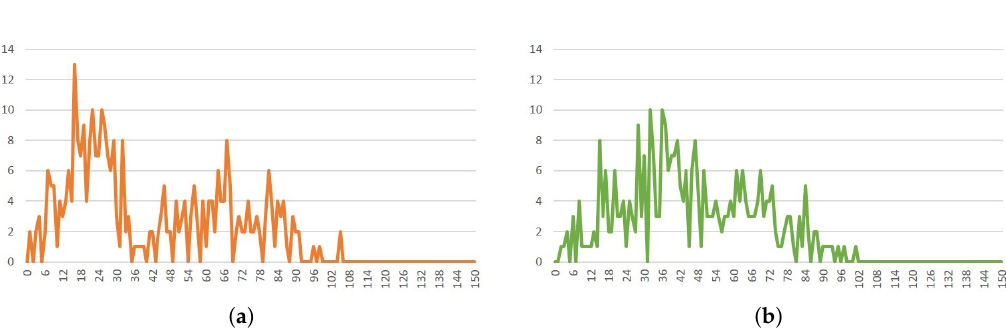
Figure 22. ( a ) The distribution when rule of thirds is considered. ( b ) The distribution for a random photo taking process.